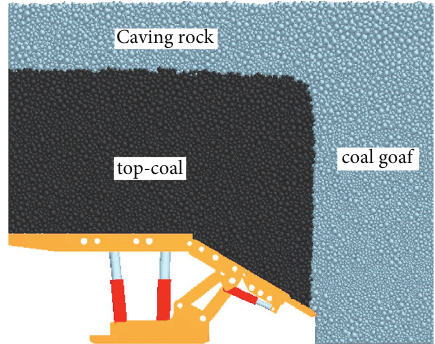
Figure 1: Simulation model of top coal caving